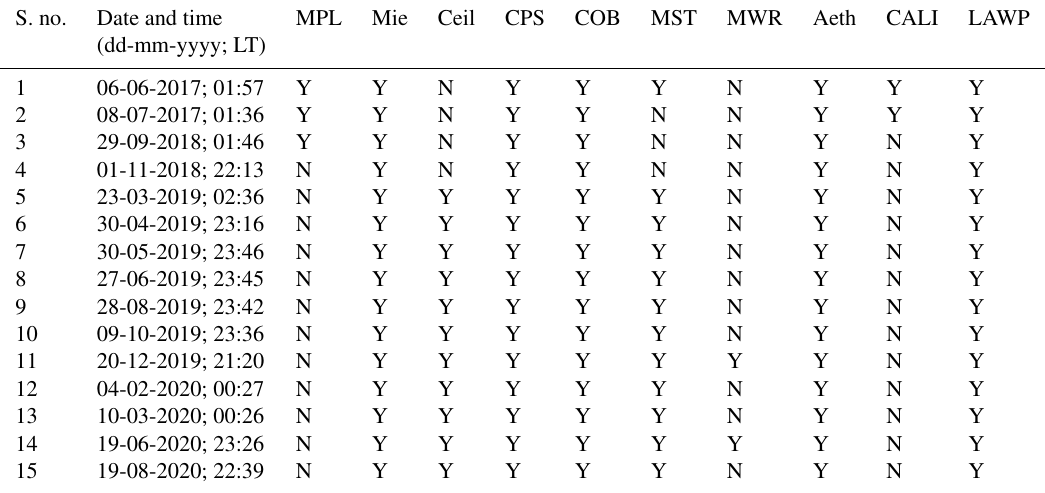
Table 2. Date and time of the BACIS campaigns and the instruments operated during the corresponding campaigns. S. no.